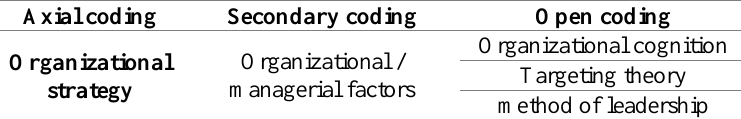
Table 5: Qualitative data coding (strategic